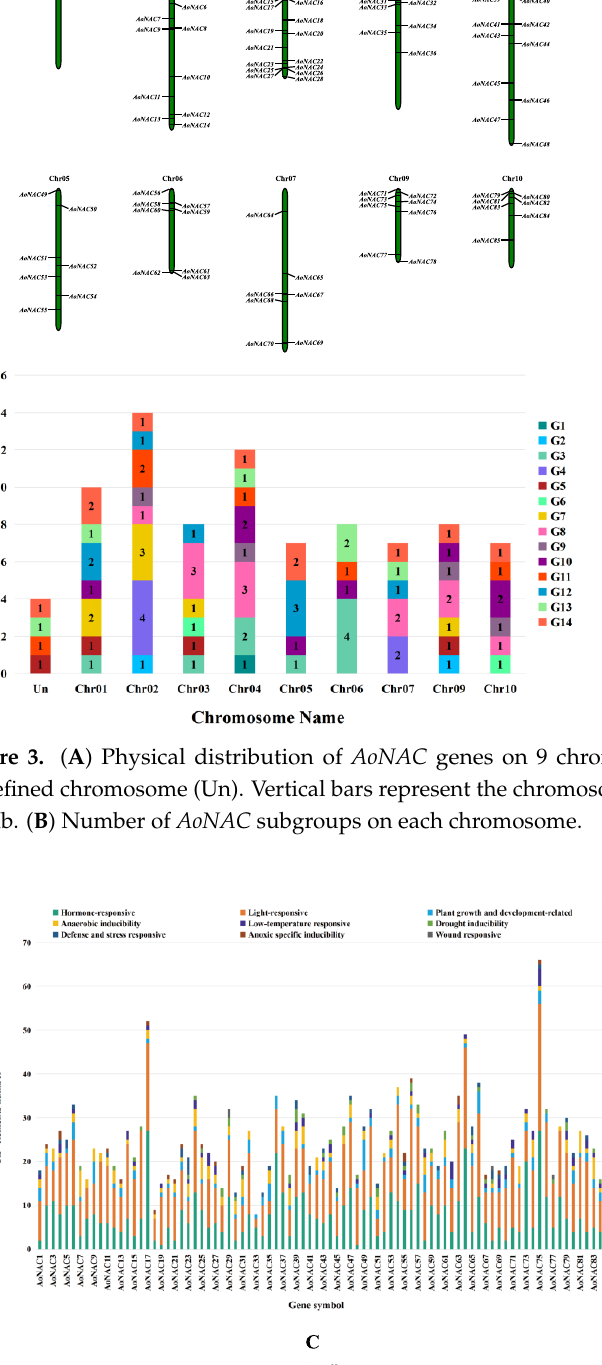
Figure 3. ( A ) Physical distribution of AoNAC genes on 9 chromosomes (Chr01 – Chr09) and an unde- fined chromosome (Un). Vertical bars represent the chromosome of A. officinalis . The scale is in 15 Mb. ( B ) Number of AoNAC subgroups on each chromosome.